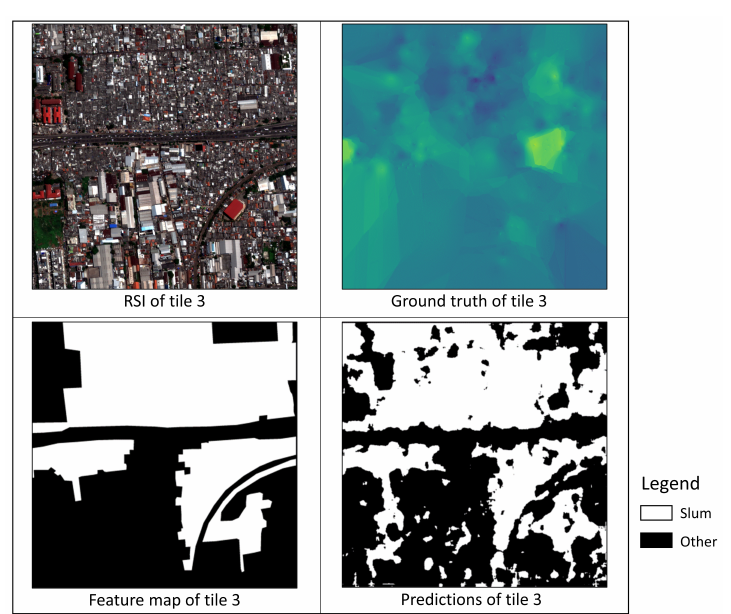
Figure A1. Outcome generated for tile-3 using Modified FCN-DK6_2, where white stands for slum area and black for other areas